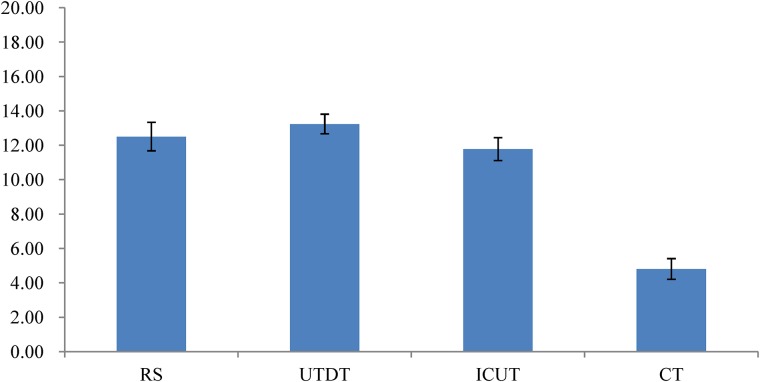
The mean of the differential attitude scores under different thinking modes in Experiment 1. Higher scores indicate larger attitude scores. Error bars indicate the SE of the differential attitude scores.